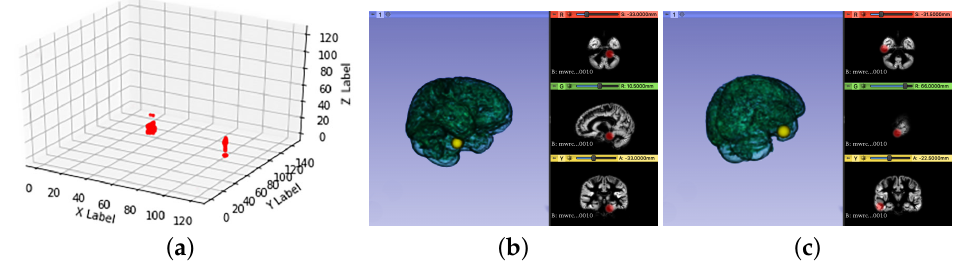
Figure 4. Visualization of the comment disorder region of nine patients. ( a ) in three-dimensional coordinate space; ( b , c ) two different suspected lesions in 3D and 2D images.